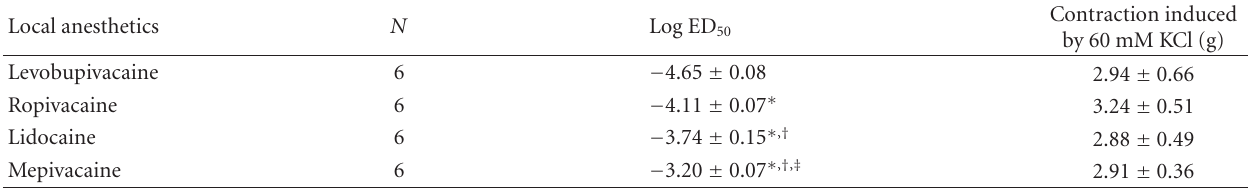
Values are expressed as mean ± SD. N : number of rats.